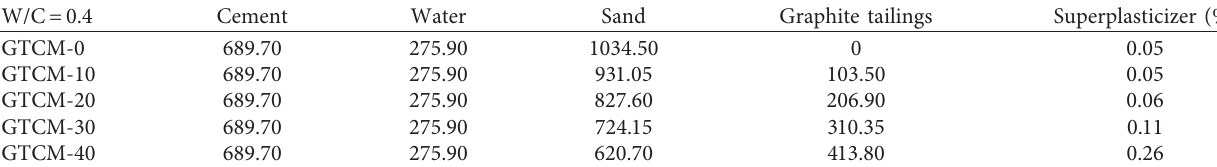
Table 5: Mixing proportions of GTCM (kg/m 3 ).